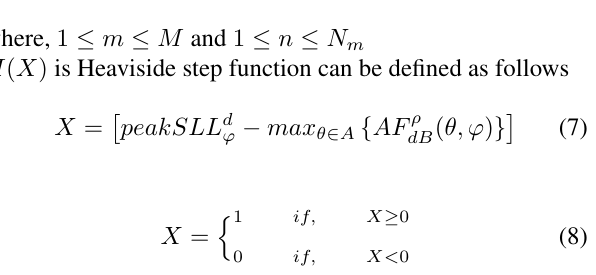
FIGURE 11: Obtained pattern at ϕ = 120 o Plane